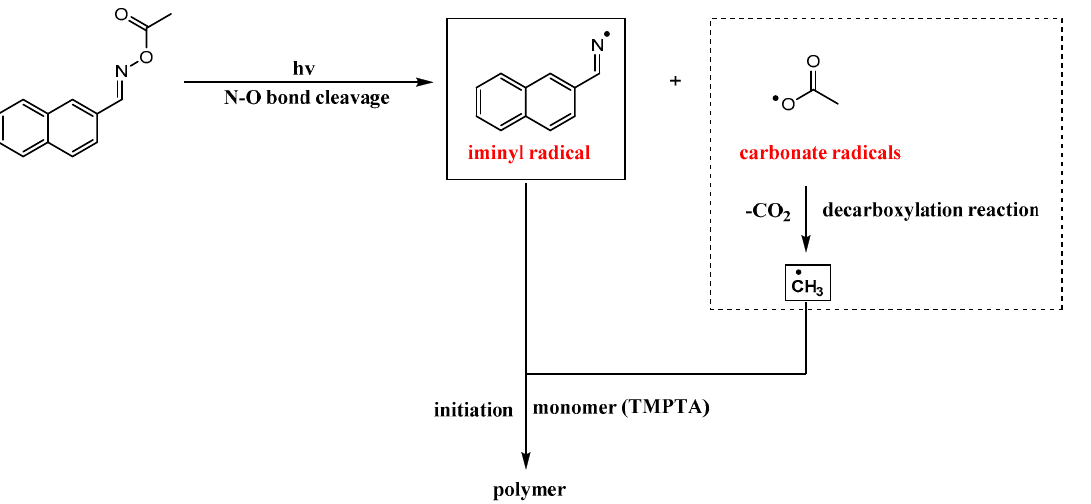
Table 2. Photo-DSC results based on UV light irradiation.